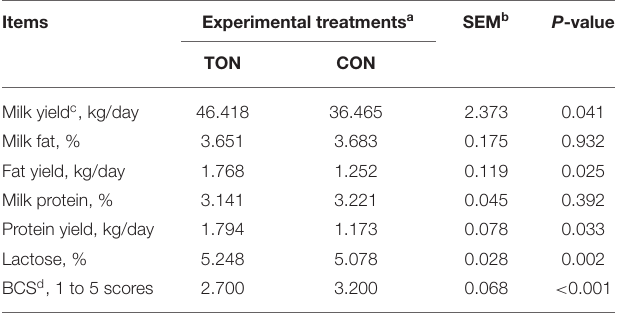
TABLE 2 | Milk yield, composition and body condition scores in dairy cow showing tongue- rolling behavior or no signs of abnormal behavior. Items Experimental treatments a